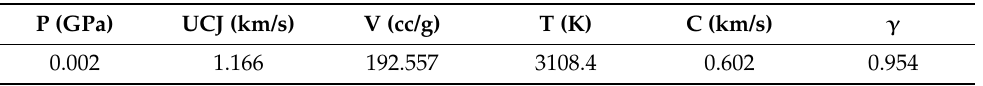
Table 1. Detonation conditions assumed in the computational thermochemical code for the Al/air explosion.